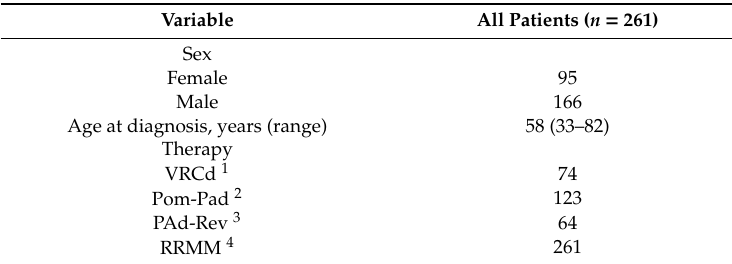
Table 1. Patient characteristics of our